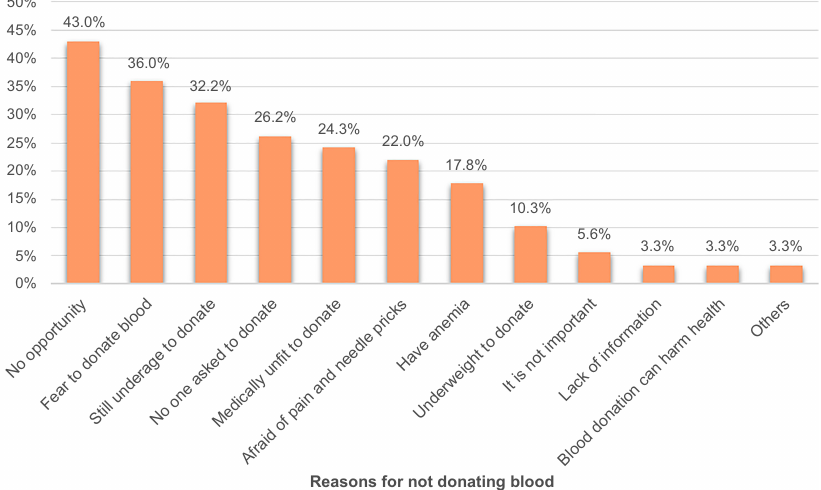
Figure 2. Reasons for